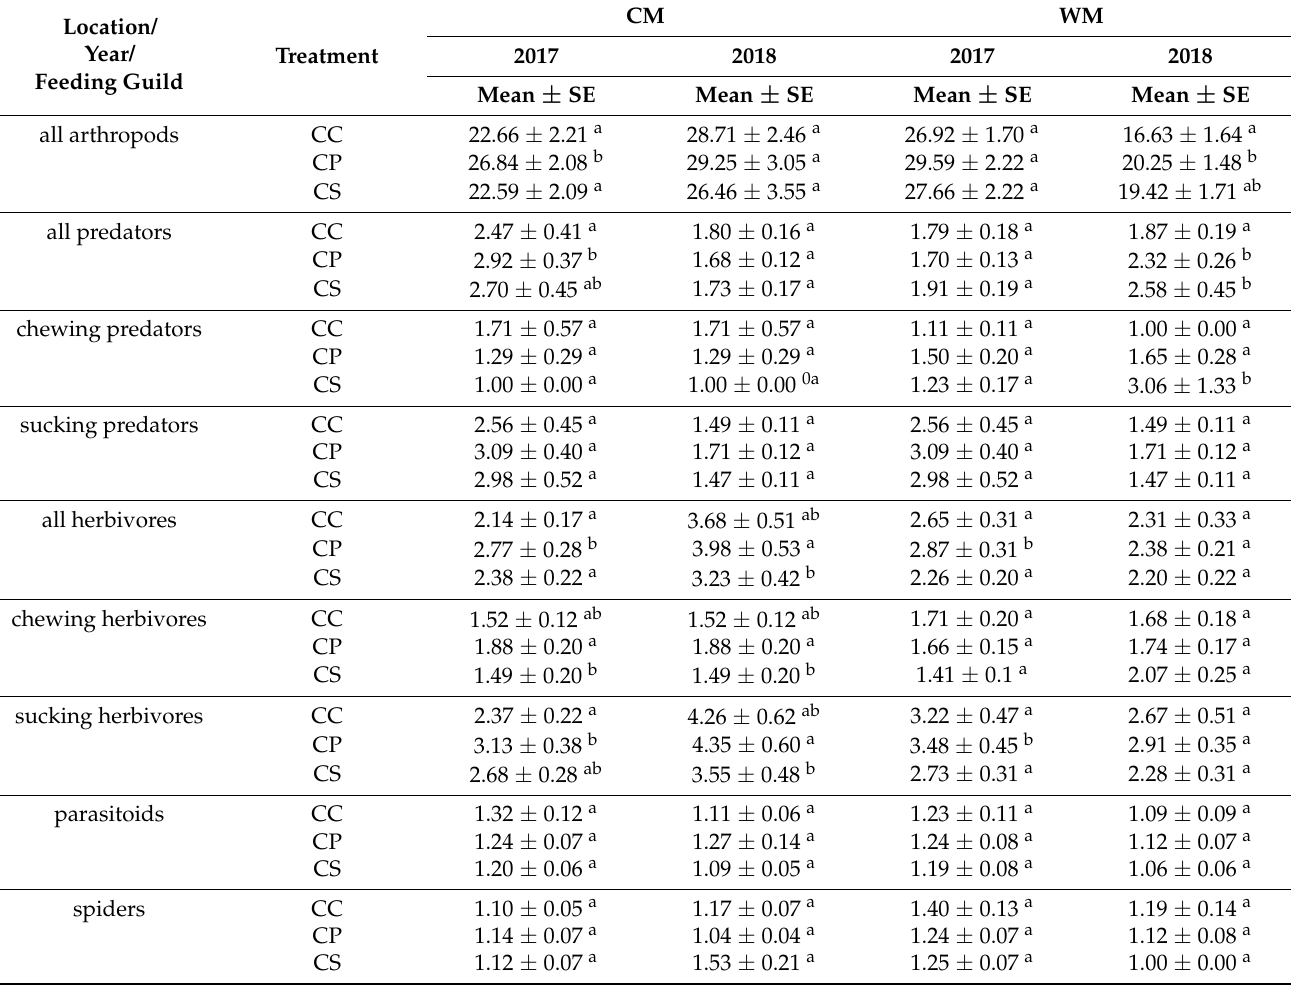
Table 2. Mean abundances of foliar pest and beneficial arthropods and their main feeding guilds sampled by sweep net in soybean during 2017 and 2018 at two field sites, Beltsville [Central Maryland (CM)] and Keedysville [Western Maryland (WM)], across three post-harvest treatments following corn harvest. For the three treatments, CC denotes cover crop planted in corn residue/stubble; CP represents chisel plowed (conventional tillage) plots; and CS (corn stubble) no action. Mean values and standard errors (Mean ± SE) and results of statistical comparisons via fitted GLMMs are